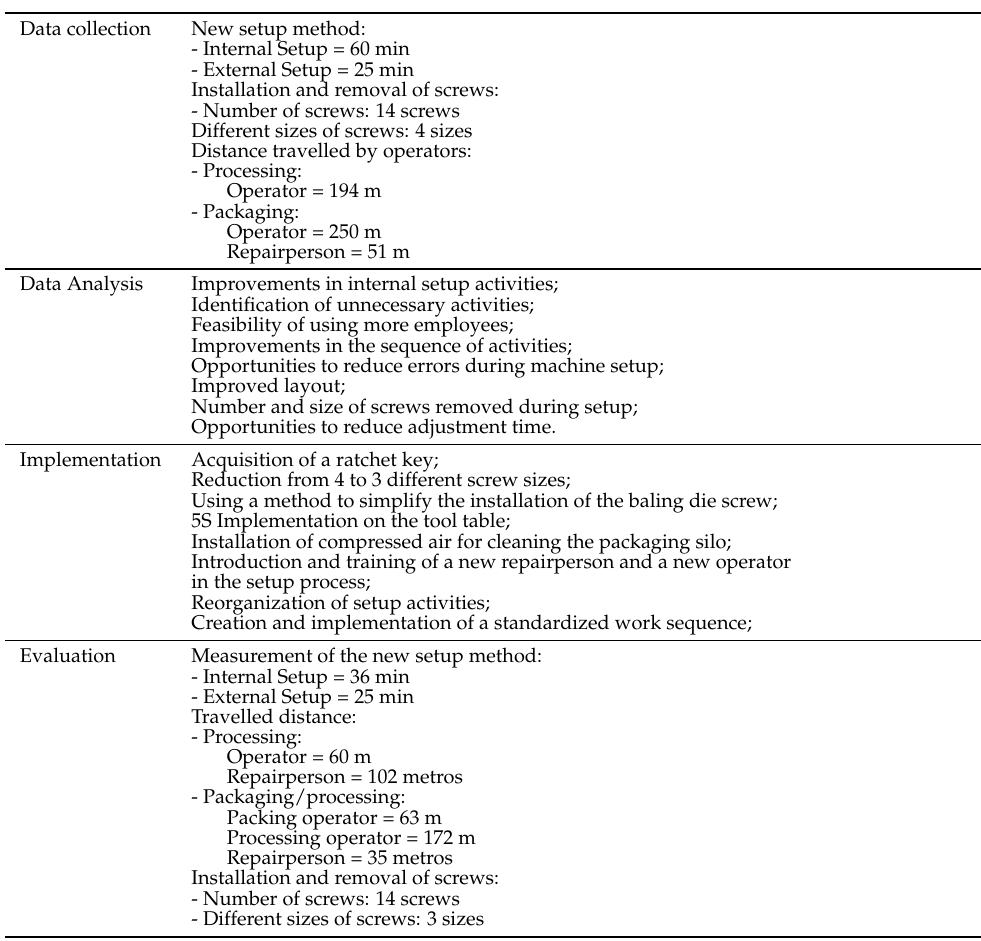
Table 4. Summary of the second cycle of action